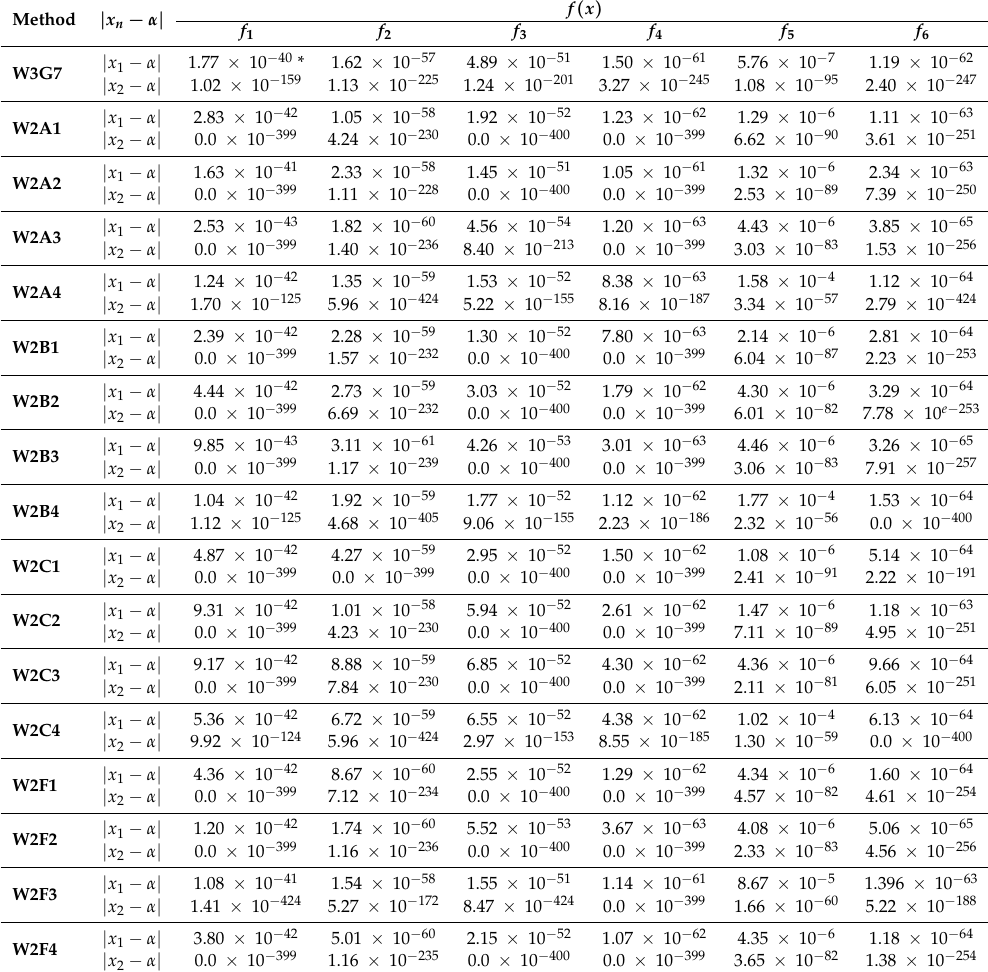
Table 4. Comparison of | x n − α | among selected methods applied to various test